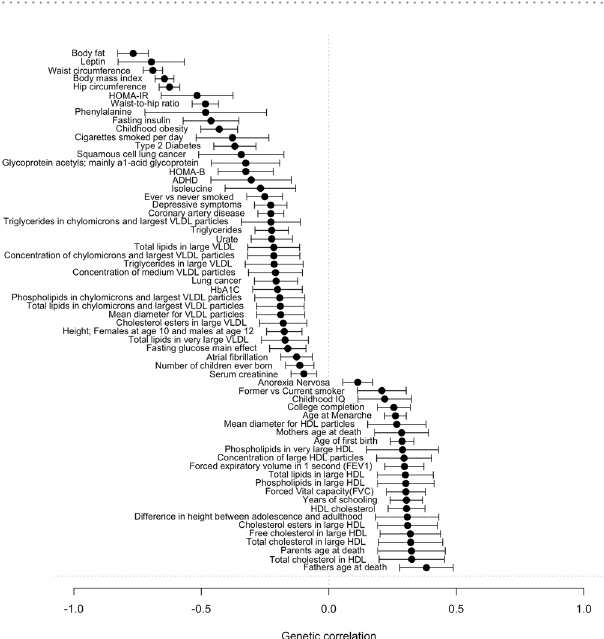
Figure 4. Significant genetic correlations with grip strength. Abbreviations: HOMA-IR, homeostasis model assessment-estimated insulin resistance; HOMA-B, homeostasis model assessment-estimated beta-cell function; ADHD, attention deficit hyperactivity disorder; VLDL, very low density lipoprotein; HbA1c, glycated haemoglobin; IQ, intelligence quotient; HDL, high density